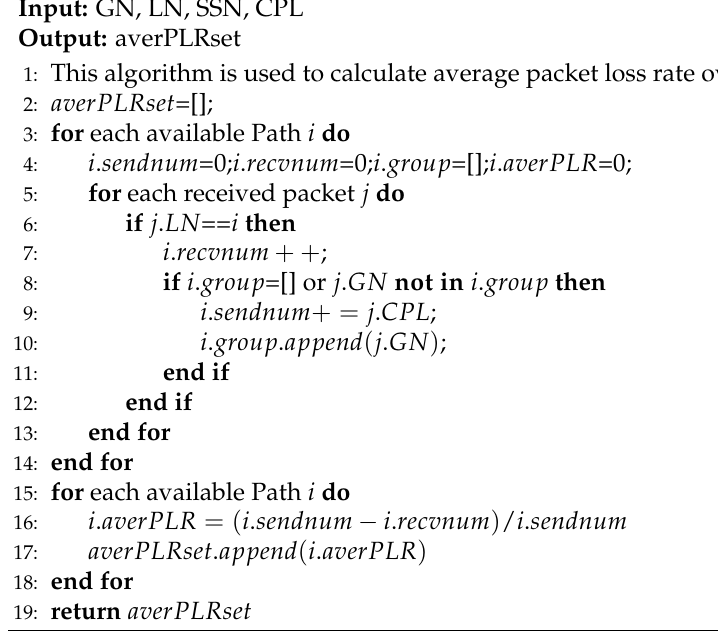
Algorithm 2 Average PLR